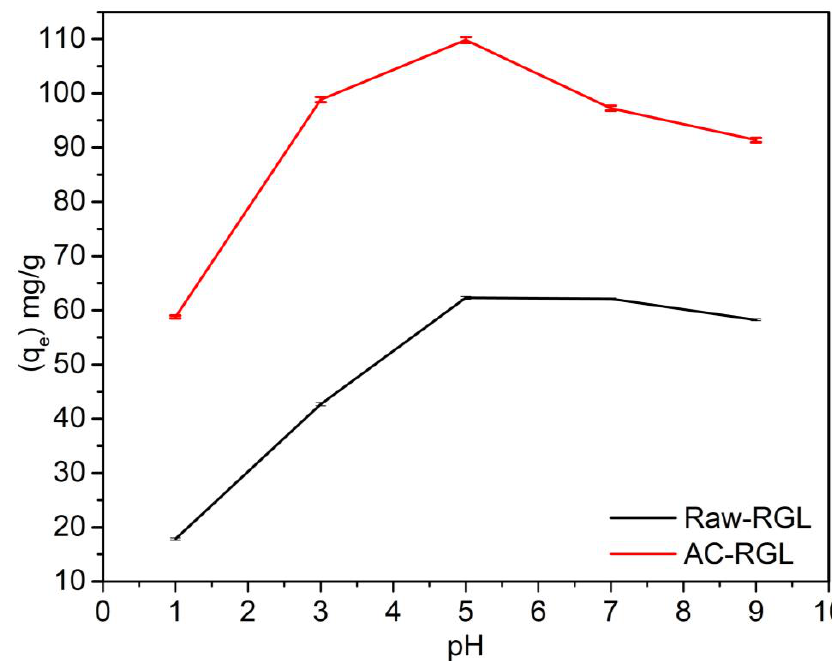
Figure 9. Effect of pH on ibuprofen uptake by Raw-RGL and AC-RGL adsorbents.